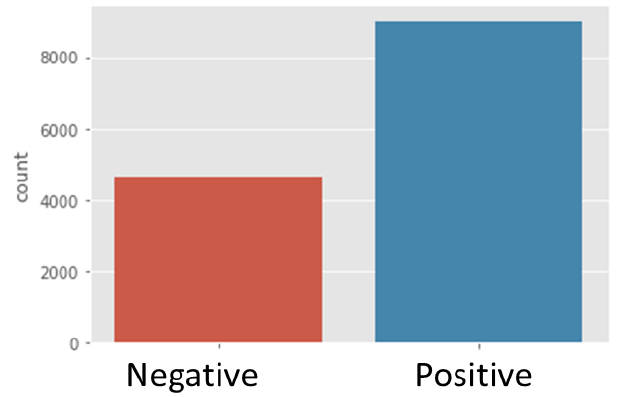
Figure 2. Negative and positive sentiment count.